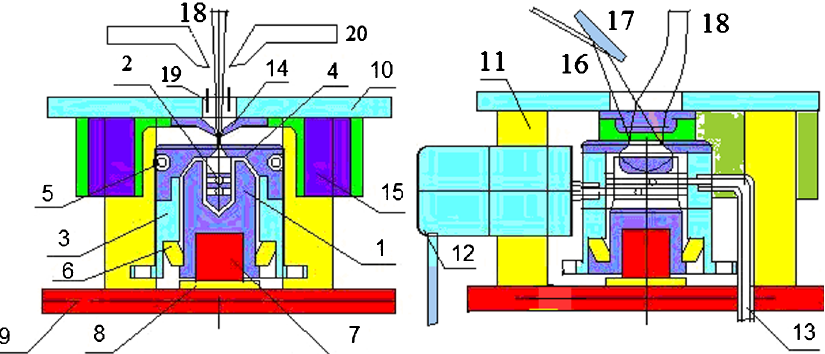
FIG. 4. Schematic of the upgraded version of the Penning discharge SPS for pulsed and cw chopped H (cid:1) beam production. (1) cathode; (2) anode; (3) source body; (4) cooled plasma plate; (5) anode cooling; (6) cathode insulator; (7) cathode cooler; (8) thermal conductive insulator (AlN); (9) cooled flange; (10) baseplate; (11) high voltage insulators; (12) gas delivery system (pulsed valve); (13) cesium delivery system; (14) extractor; (15) magnet (SmCo) + coils; (16) laser beam for Cs diagnostic/trapping; (17) mirror; (18) negative ion beam; (19) suppressor/deflector; (20) accelerating electrode.